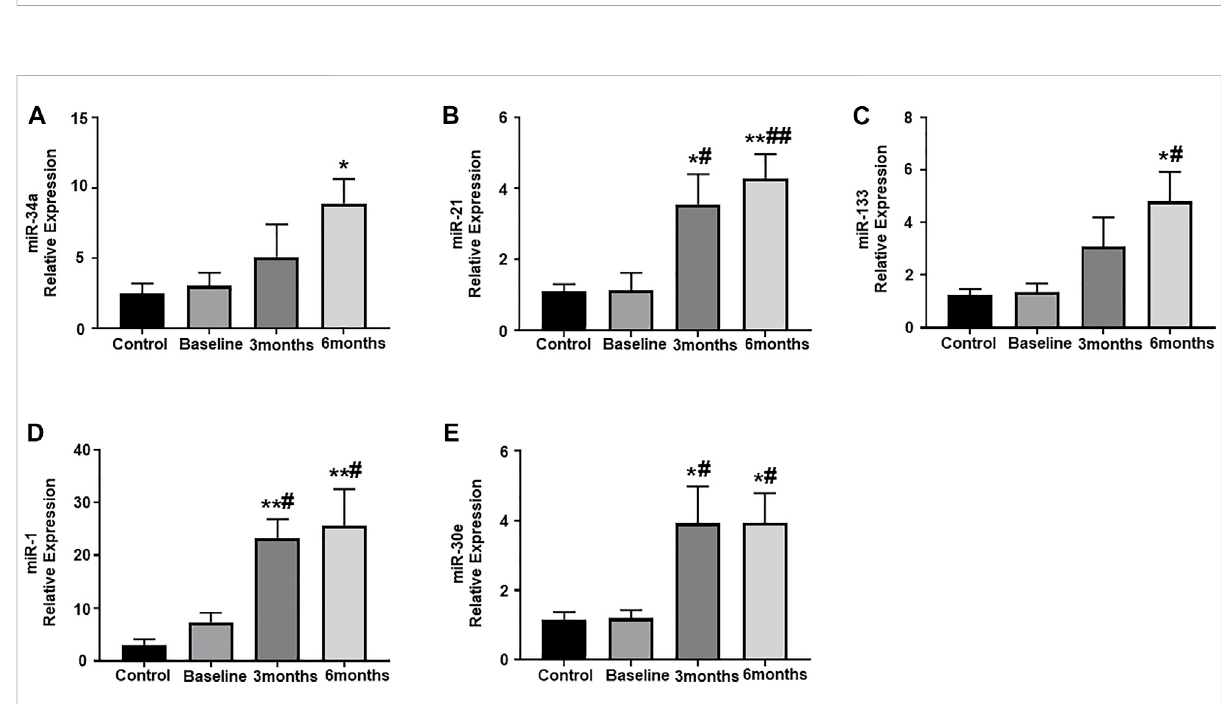
FIGURE 2 Assessment of circulating plasma miRNA expression. Quantitative analysis of circulating plasma miRNA expression by qRT-PCR: (A) miR-34a, (B) miR-21, (C) miR-133, (D) miR-1, (E) miR-30e. Values represent means ± SEM. * p < 0.05 vs. Control, ** p < 0.01 vs. Control, # p < 0.05 vs. Baseline, ## p < 0.01 vs.